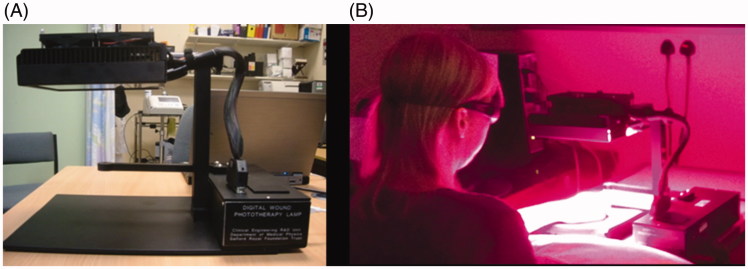
Light-based treatment for SSc-related DUs. A: Side profile of the light device. B: The light device in operation treating an extensor aspect DU in a patient with SSc. The distance from the panel of LEDs to the treatment area is approximately 15 cm.